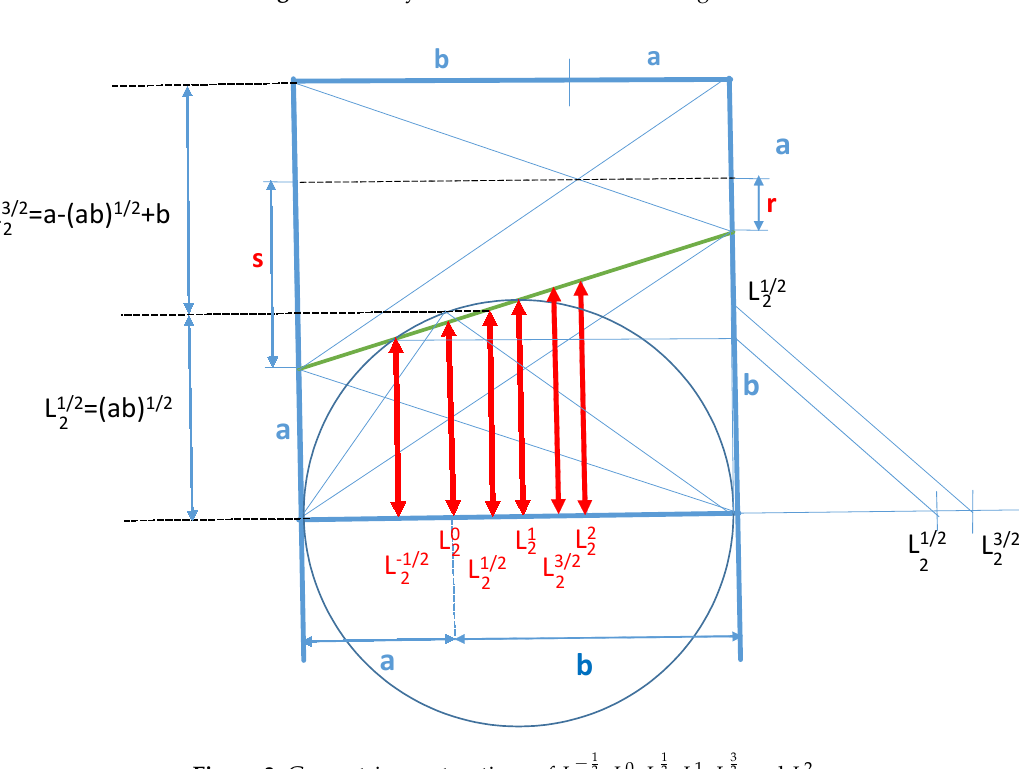
Figure 3: Geometric constructions of L (cid:0)